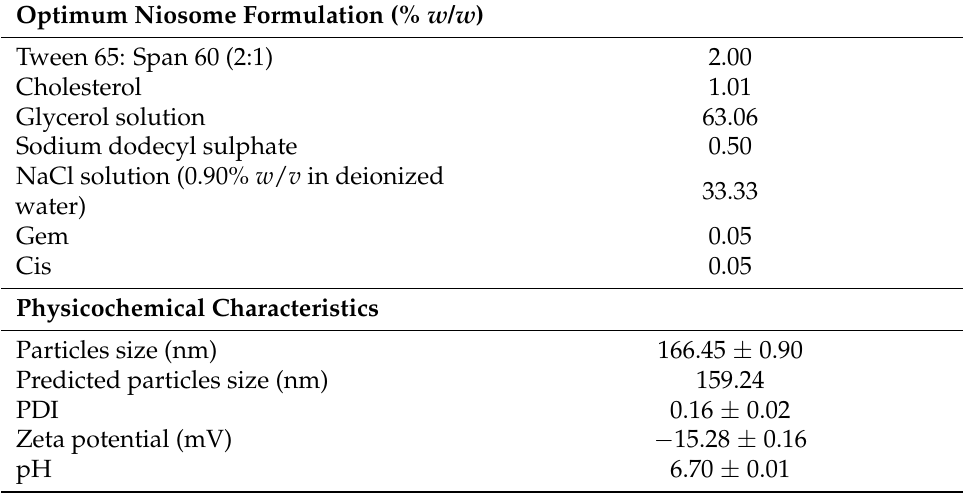
Table 6. Optimum composition and physicochemical characteristics of the niosome